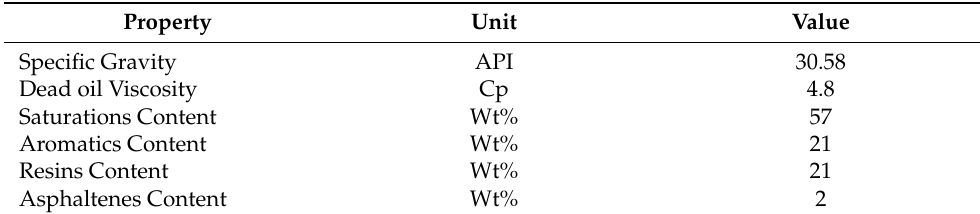
Table 2. Properties of the crude